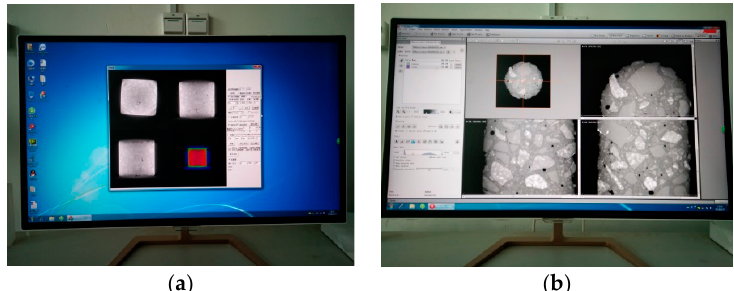
Figure 4. The Preparations for ICT. ( a ) Debugging Setup Interface; ( b ) ICT Radiation Source Preheating.